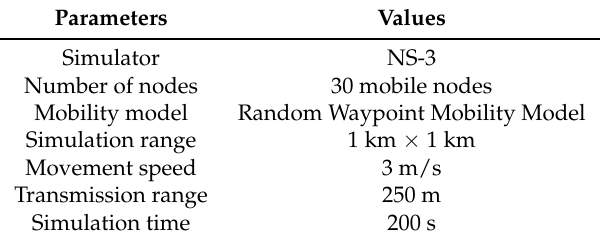
Table 2. Simulation Parameters and Values.